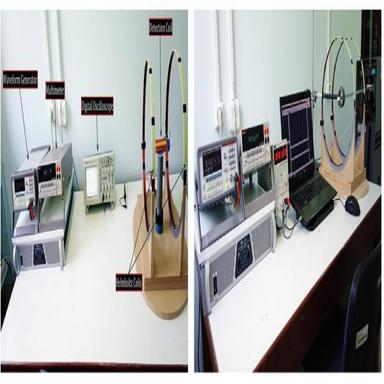
(a) Experimental setup for measuring the ribbon's frequency response, (b) a panoramic view of the non-frequency response experimental setup, (c) a detailed view of the left side of the non-frequency response experimental setup, (d) a detailed view of the right side of the non-frequency response experimental setup.